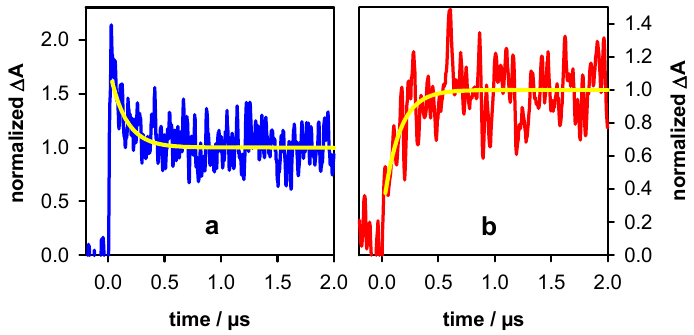
Figure 7. Transient absorption signals recorded at 400 nm ( a ) and 620 nm ( b ) for N 2 O saturated solutions of TEL21/K + . Yellow lines correspond to mono-exponential decay and rise with the same time constant of 0.14 µs. ∆ A was normalized to 1 at 2 µs.